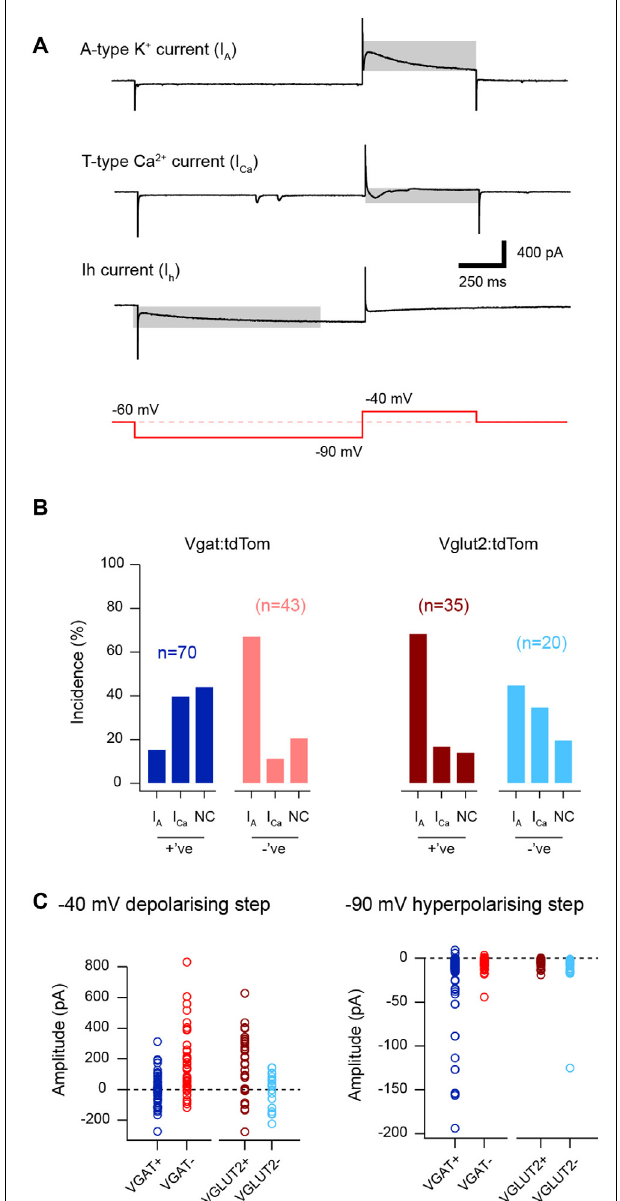
FIGURE 3 | Subthreshold voltage-activated current expression in excitatory and inhibitory populations. (A) Traces show representative responses to a voltage step protocol (red lower trace). Three subthreshold voltage-activated currents are identified (highlighted by gray rectangle). These include outward A-type potassium currents (upper trace), inward low threshold T-type calcium currents (middle), and inward hyperpolarization-activated cation currents (I h , lower). (B) Plots show the relative incidence of voltage-activated currents taken from the response to a current step from − 90 mV to − 40 mV. A-type currents were frequently observed in recordings from excitatory populations (vGLUT2+ and VGAT − , brown and red bars) whereas T-type Ca-currents were more commonly expressed by inhibitory neurons (VGAT+ and VGLUT2 − , blue and light blue bars). Note, between 15–40% of recordings in each population did not exhibit a subthreshold current response to this step and they are termed no current (NC) on the bar plots. (C) Plots showing the peak amplitude of the subthreshold current responses for the depolarizing ( Continued